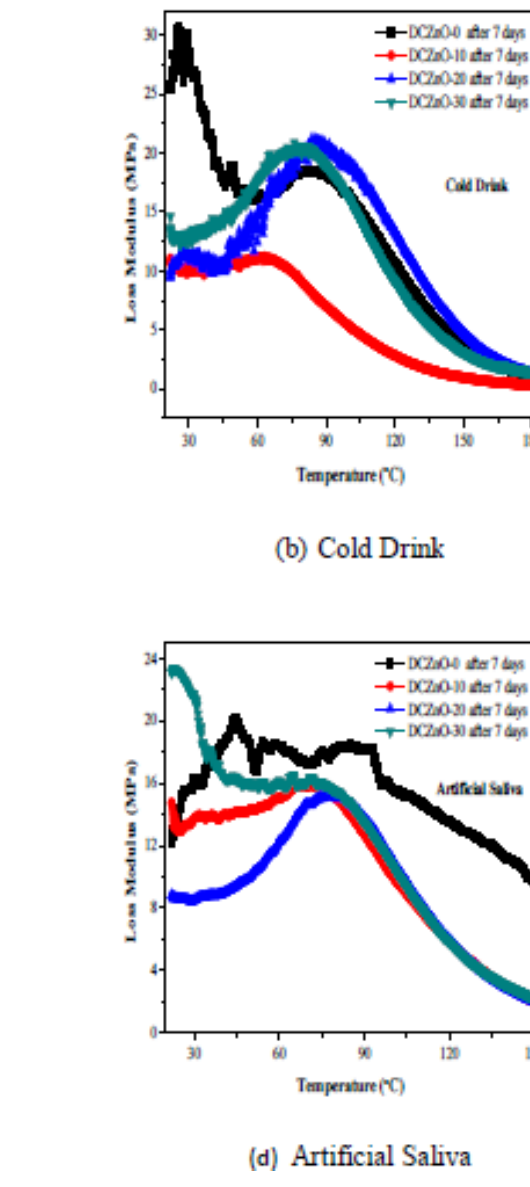
Figure 4: Variation of loss modulus of (a) Post cured sample (b) sample kept in Cold Drink for 7 days (c) sample kept in distilled water for 7 days (d) sample kept in artificial saliva for 7